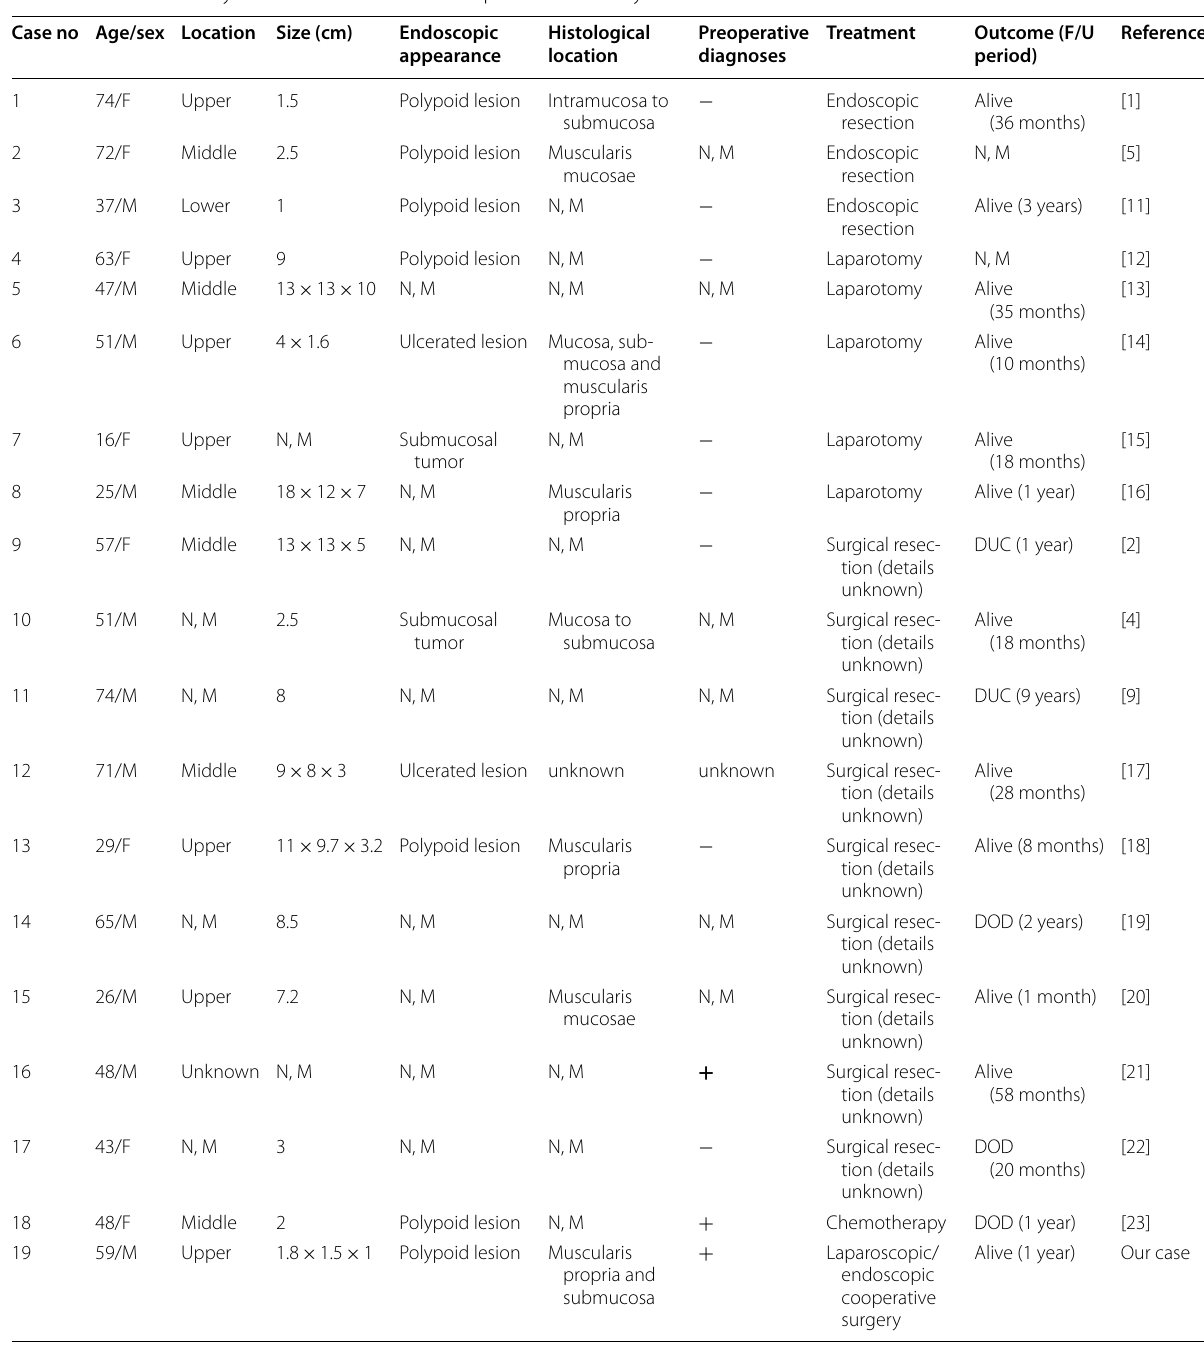
M male, F female, N, M not mentioned, F/U follow-up, DOD dead of disease, DUC dead of unknown cause